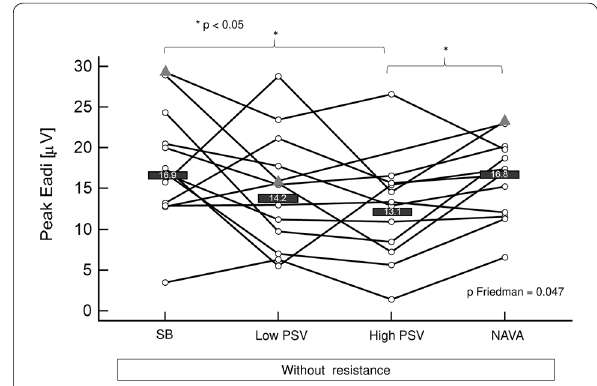
Fig. 3 Effect of unstressed assisted ventilation on peak electrical activity of the diaphragm (peak Eadi). SB unstressed (without resistance) spontaneous non‑assisted breathing, PSV pressure support ventilation, NAVA neurally adjusted ventilatory assist. The data of all the participants are displayed in the figure. Patients for whom all the conditions were available are represented as white circles. Patients for whom one or more conditions could not be recorded are represented as gray triangles. Only the subjects represented as white circles were considered for median calculations and Friedman